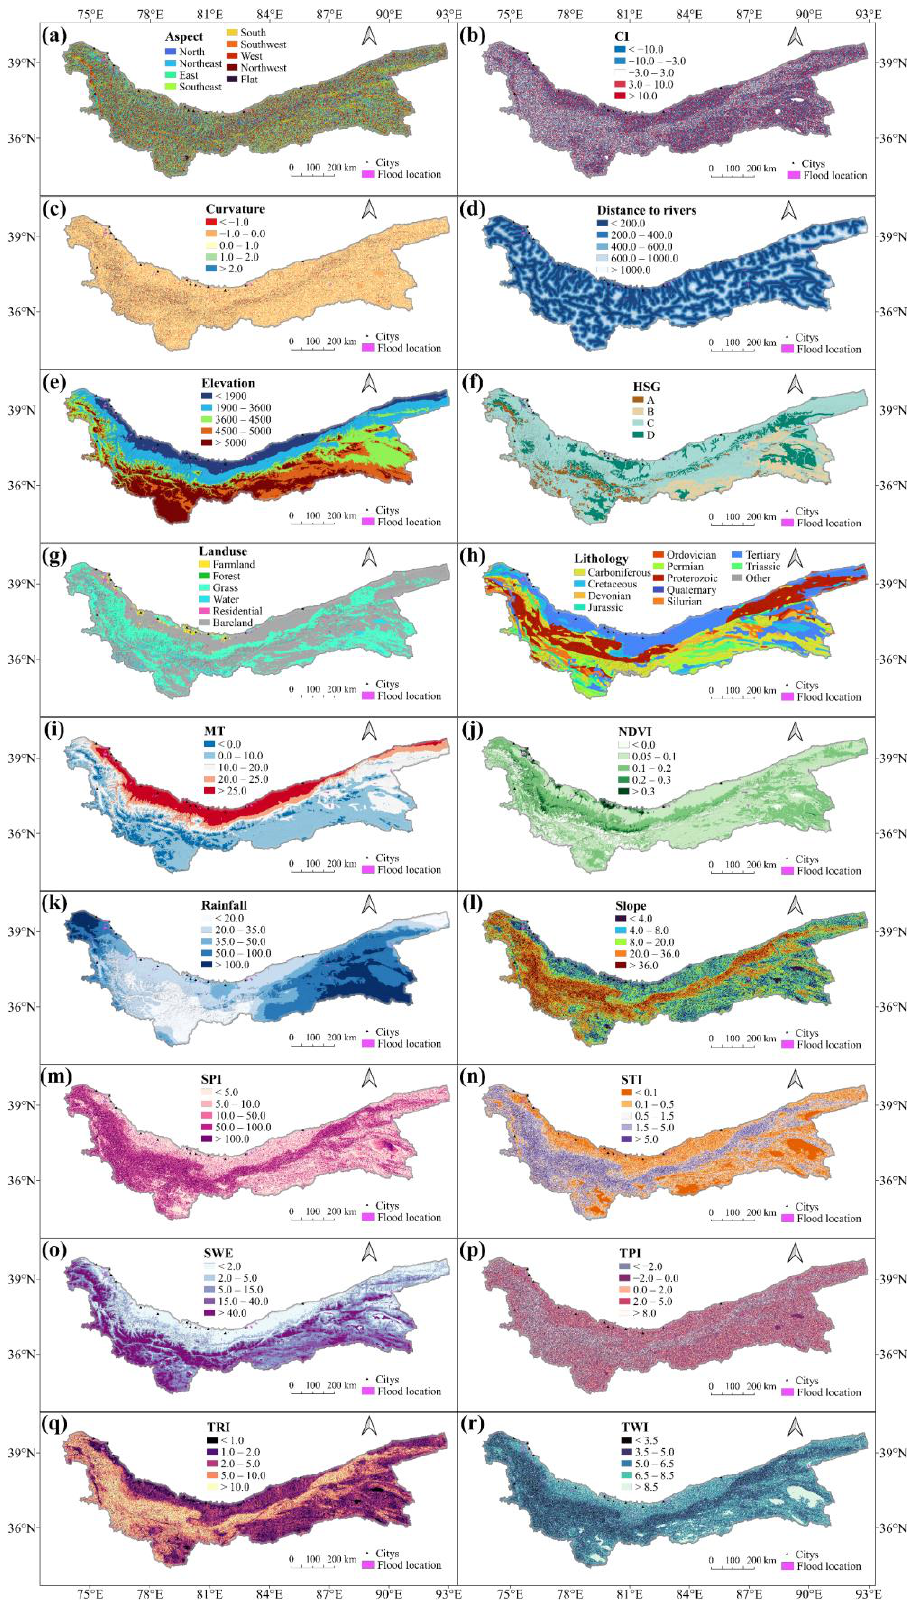
Figure 2. Conditioning factor maps: ( a ) aspect, ( b ) CI, ( c ) curvature, ( d ) distance to rivers, ( e ) elevation, ( f ) HSG, ( g ) land use, ( h ) lithology, ( i ) MT, ( j ) NDVI, ( k ) rainfall, ( l ) slope, ( m ) SPI, ( n ) STI, ( o ) SWE, ( p ) TPI, ( q ) TRI, ( r ) TWI.